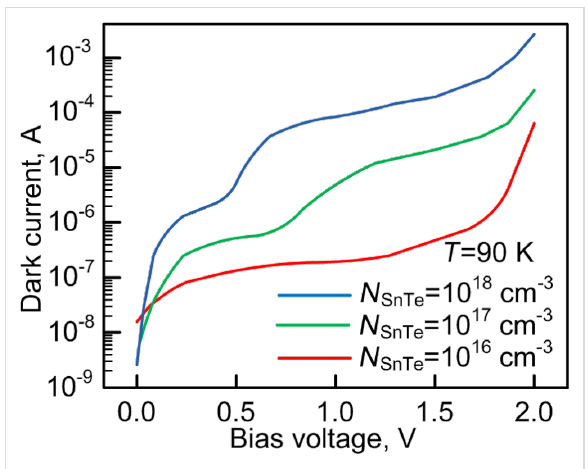
Figure 9: Dark I – V characteristics of the different doped samples.